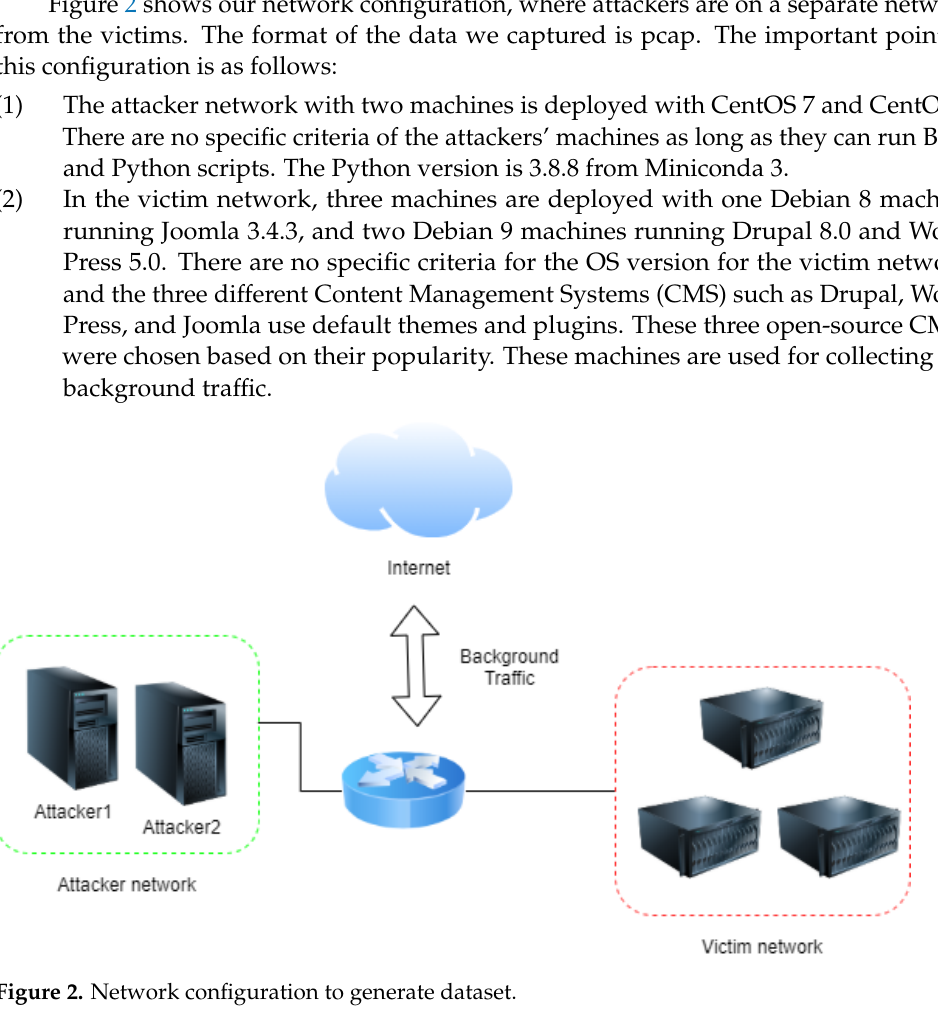
Figure 2. Network configuration to generate